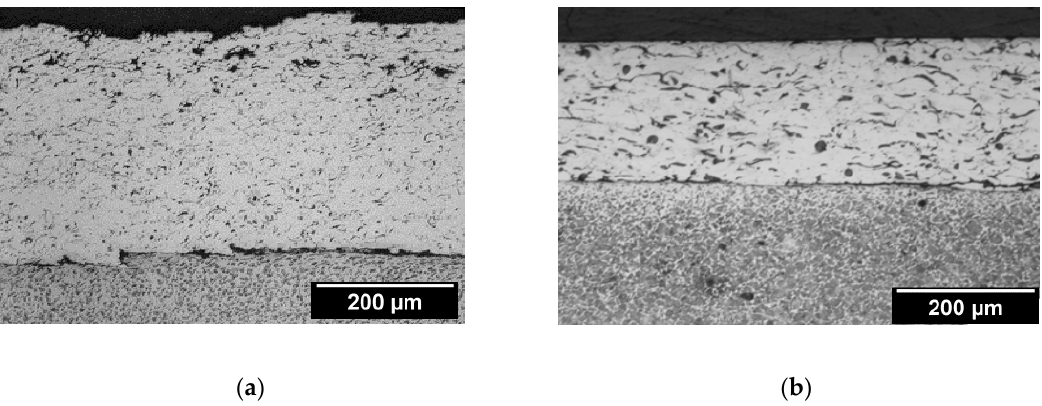
Figure 10. Microstructure of Ni–5%Al alloy coating, etched with 4% HNO 3 . ( a ) After flame spraying, the roughness of the coating was Ra = 13.3 µ m. ( b ) After cold rolling ( φ 200 mm) for a relative draft of 10%, the roughness of coating was Ra = 0.28 µ